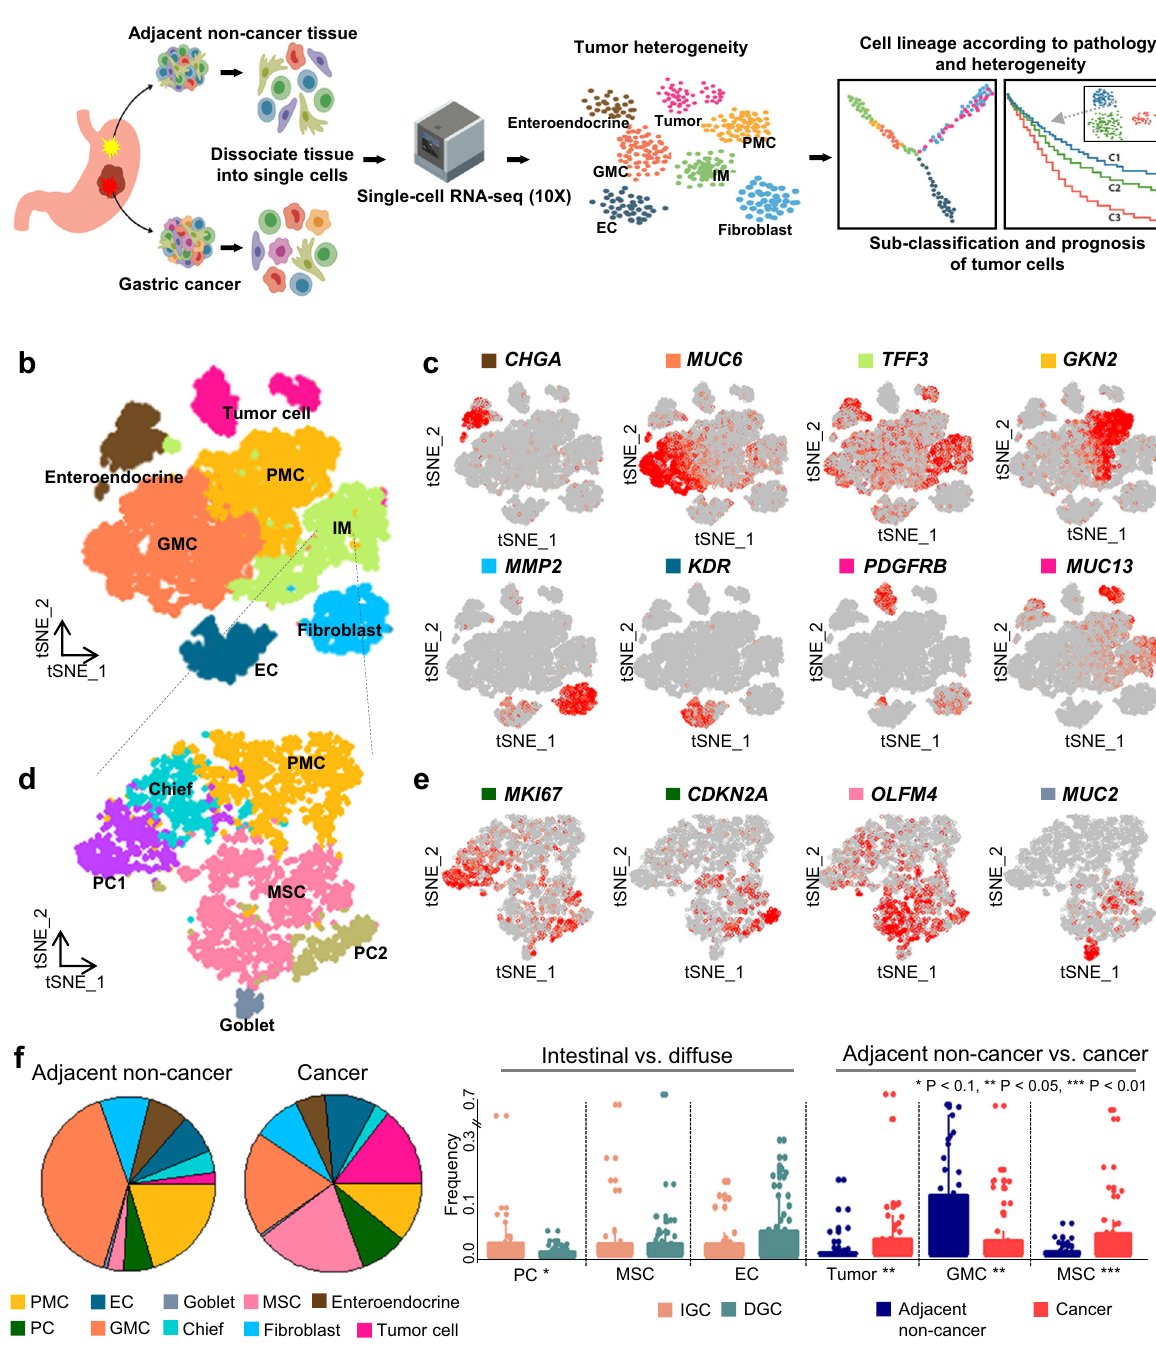
Fig. 1 Single-cell pro fi ling of adjacent normal and gastric cancer tissues. a Overview of single-cell RNA-seq analysis of the adjacent non- cancer ( n = 24) and gastric cancer (GC) tissue ( n = 24) from 24 patients. b t-Stochastic neighbor embedding (t-SNE) map of fi ltered 13,022 single cells in the adjacent non-cancer and cancer tissues. Colors represent cell types based on the expression of known marker genes: endothelial cell (EC), enteroendocrine, fi broblast, gland mucous cell (GMC), intestinal metaplasia (IM), tumor cell, pit mucous cell (PMC). c t-SNE plot showing the expression of marker genes for seven cell types. d t-SNE plot showing sub-clustering of IM cells: chief cells, goblet cells, metaplastic stem-like cells (MSCs), PMC, proliferative cell 1 (PC1), and proliferative cell 2 (PC2). e t-SNE plot showing the expression of marker genes for three cell types. PGC was highly expressed in chief cell (Supplementary Fig. 5b). f Pie charts represent the distribution of ten cell types in the adjacent normal tissue and cancer lesion (left). Bar plots show the frequency of speci fi c cell types in different tissue comparisons (right). Points on the bar plots represent individual samples; P values were calculated by the t